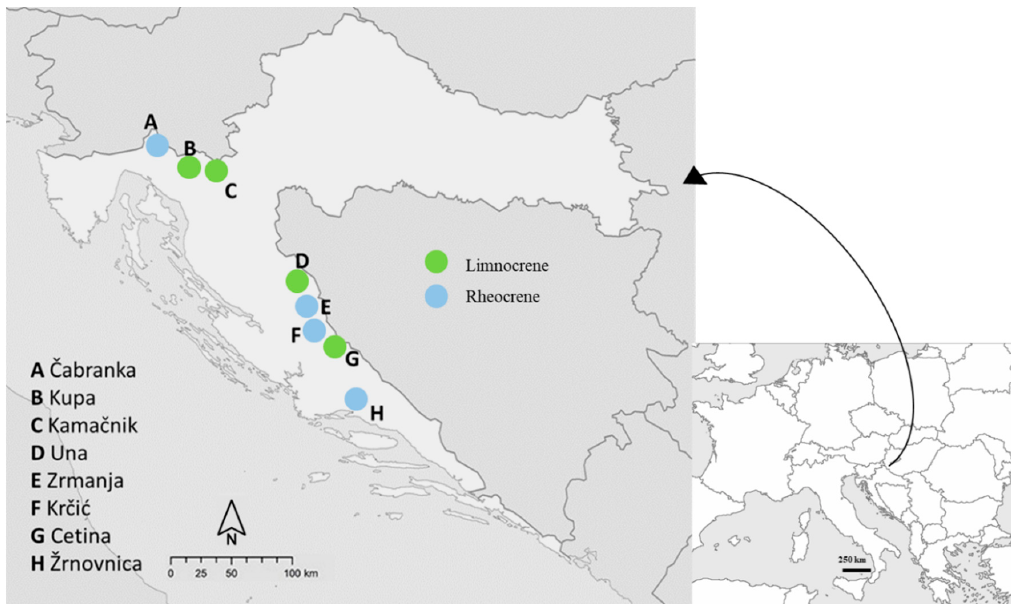
Figure 1. Map of the study area with the locations of the eight karst springs.